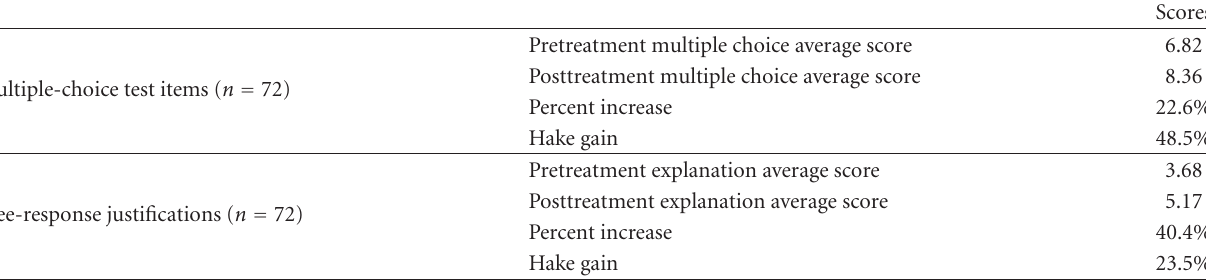
Table 1: Summary of pre- and posttreatment geologic evolution concept test